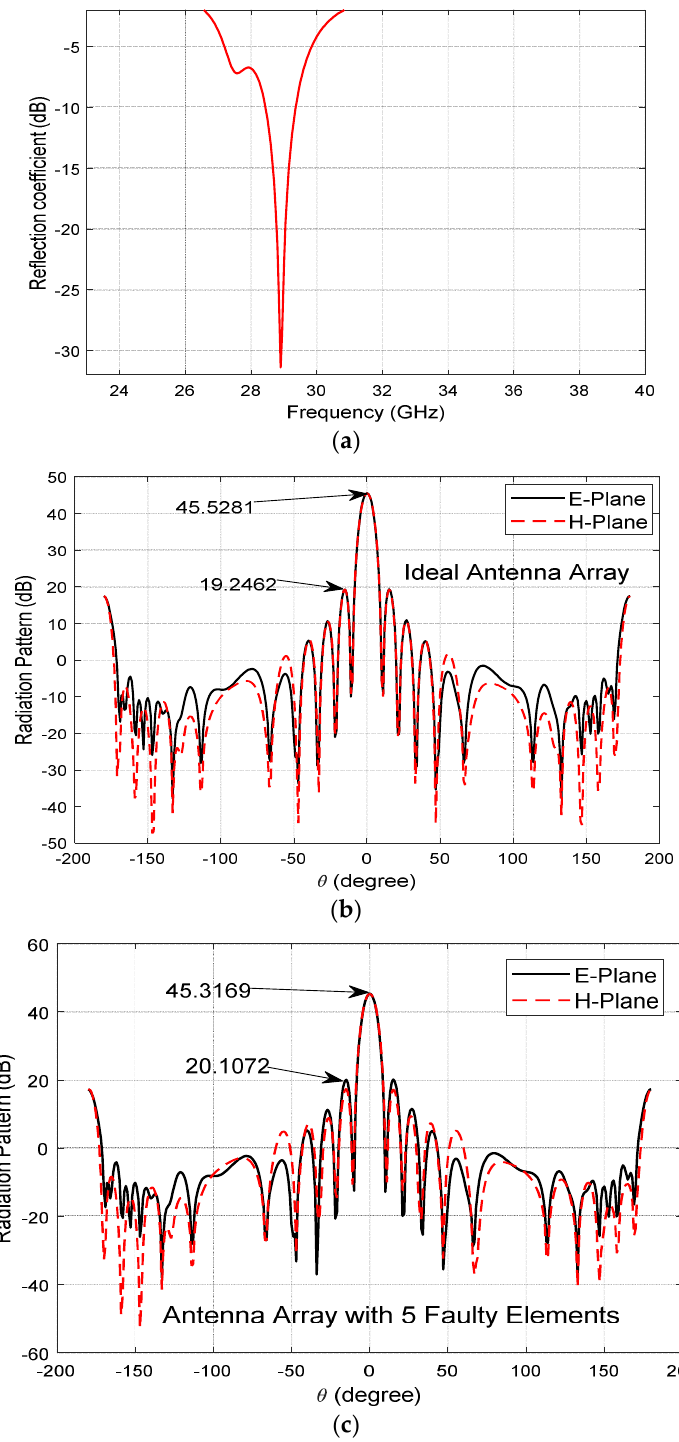
Figure 9. The antenna array for diagnostic purposes: ( a ) S-parameter; ( b ) RA radiation pattern; ( c ) AUT radiation pattern.